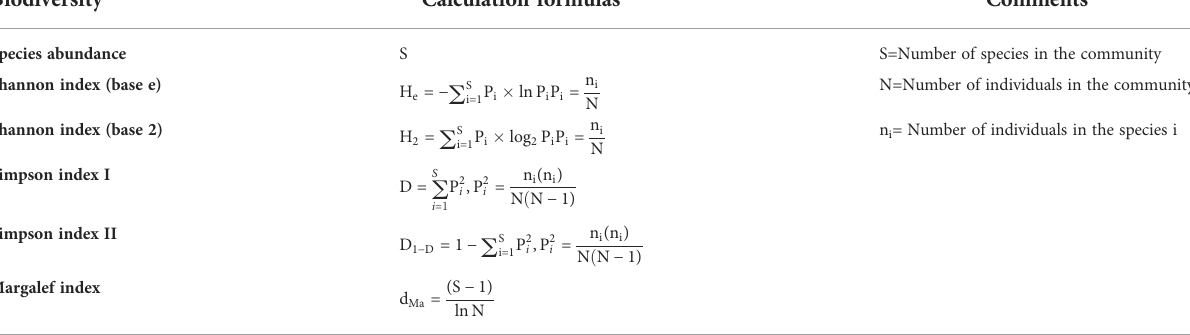
TABLE 1 Calculation methods of the diversity